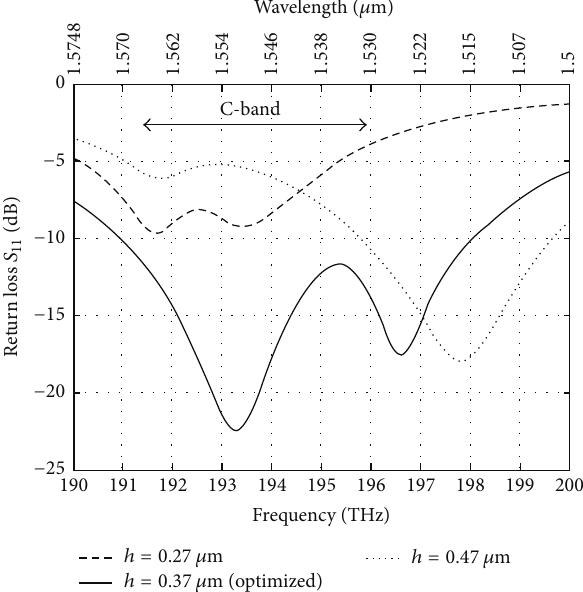
Figure 4: Optimization of height of hexagonal